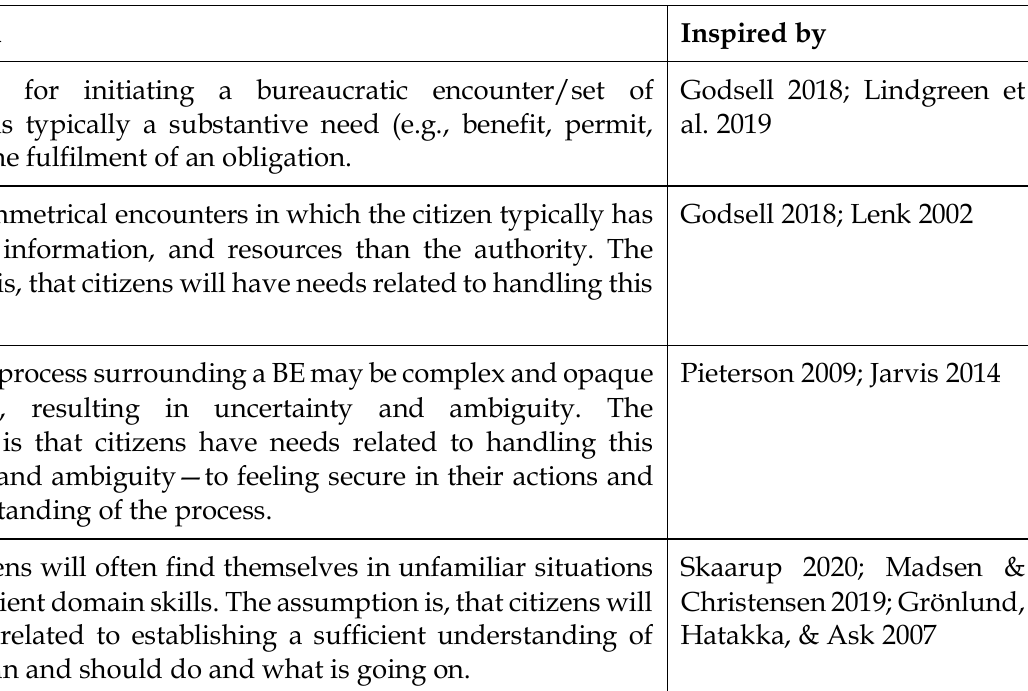
Table 1. Initial